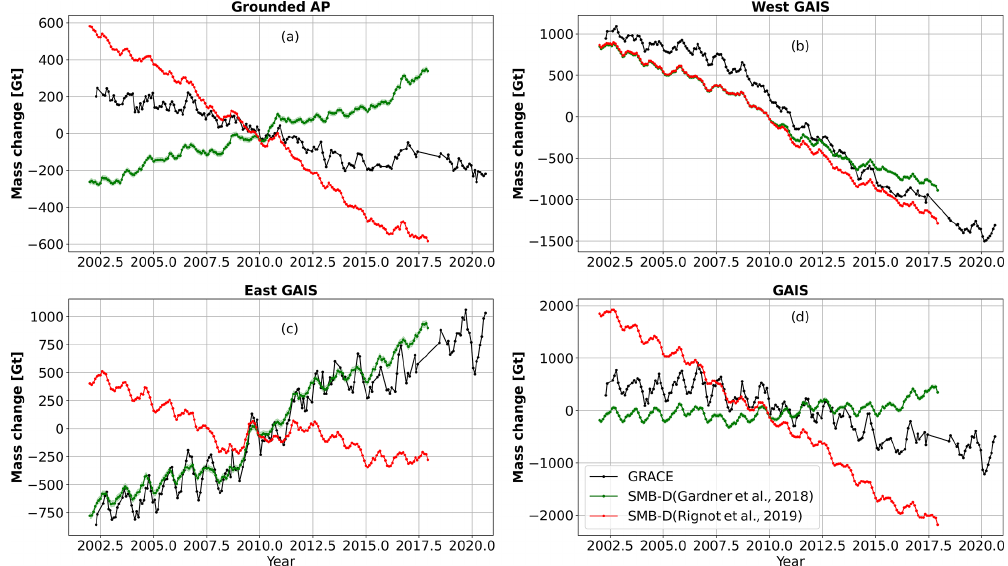
Figure 8. Integrated relative mass change over the grounded Antarctic Peninsula (a) , the grounded West AIS (b) , grounded East AIS (c) , and the GAIS (d) . GRACE relative mass change from 2002 to 2020 (black graph). SMB minus discharge (green/red graphs). SMB values are from the Dyn15 simulation, and discharge values are derived by Gardner et al. (2018) (in green) and Rignot et al. (2019) (in red). Note that the y axis differs from panel to